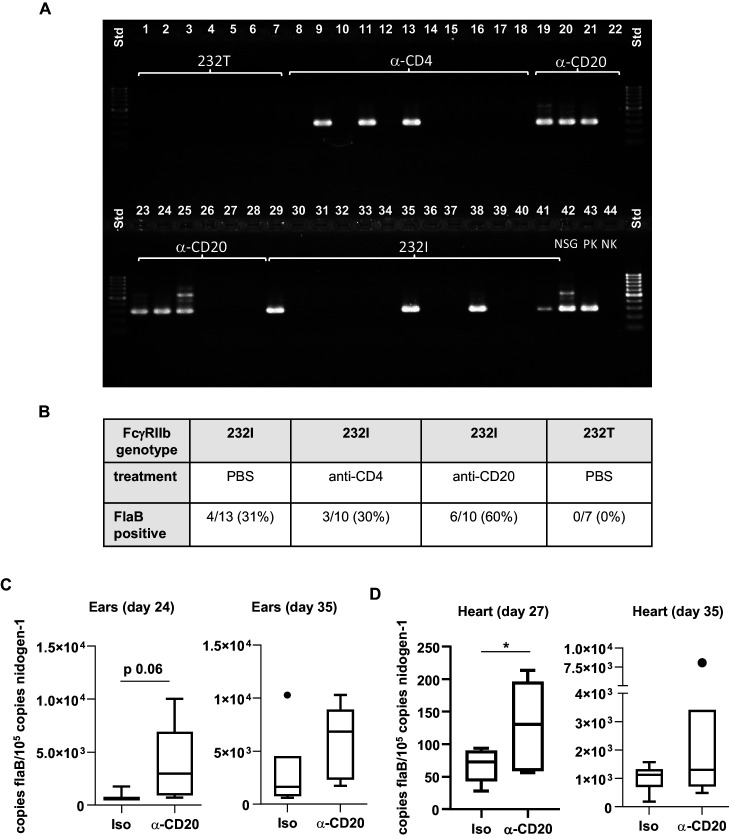
Effect of human FcγRIIb alleles, T cells and B cells on B. burgdorferi load and on pathogen-specific immune responses.(A) Shown is an ethidium bromide stained agarose gel electrophoresis of a B. burgdorferi flagellin-specific nested PCR performed on ear tissue of humanized mice carrying the functional (232I, lanes 29–41) or non-functional (232T, lanes 1–7)) FcγRIIb alleles 2 weeks after infection with B. burgdorferi. Where indicated, humanized, infected mice were injected with B cell (α-CD20, lanes 19–28) and CD4 T cell (α-CD4, lanes 8–18) specific antibodies to deplete the respective immune cell subsets. In the first and last lanes, a size standard (std; 100 base pair ladder) was loaded. In lanes 42–43, a sample of a previous positively tested non-humanized infected mouse sample (NSG), a positive control (PK) (B. burgdorferi positive tick lysate) and a negative control (NK) were loaded as controls. (B) Presented is a table summarizing the effect of FcγRIIb alleles and B cell or CD4 T cell depletion on B. burgdorferi infection in humanized mice, including the number of positively tested animals and the calculated percentage values (in brackets). (C, D) Shown are box and whisker plots depicting the pathogen load (B. burgdorferi flaB copy numbers normalized to mouse nidogen-1 copy numbers) in ears (C) and hearts (D) of infected humanized mice treated with an isotype control (Iso) or CD20-specific antibody (α-CD20) (as described in Figure 3A) at the indicated timepoints after infection with B. burgdorferi. n = 5–7 mice per group. An unpaired Student’s t-test was used to evaluate statistical significance. *p<0.05.